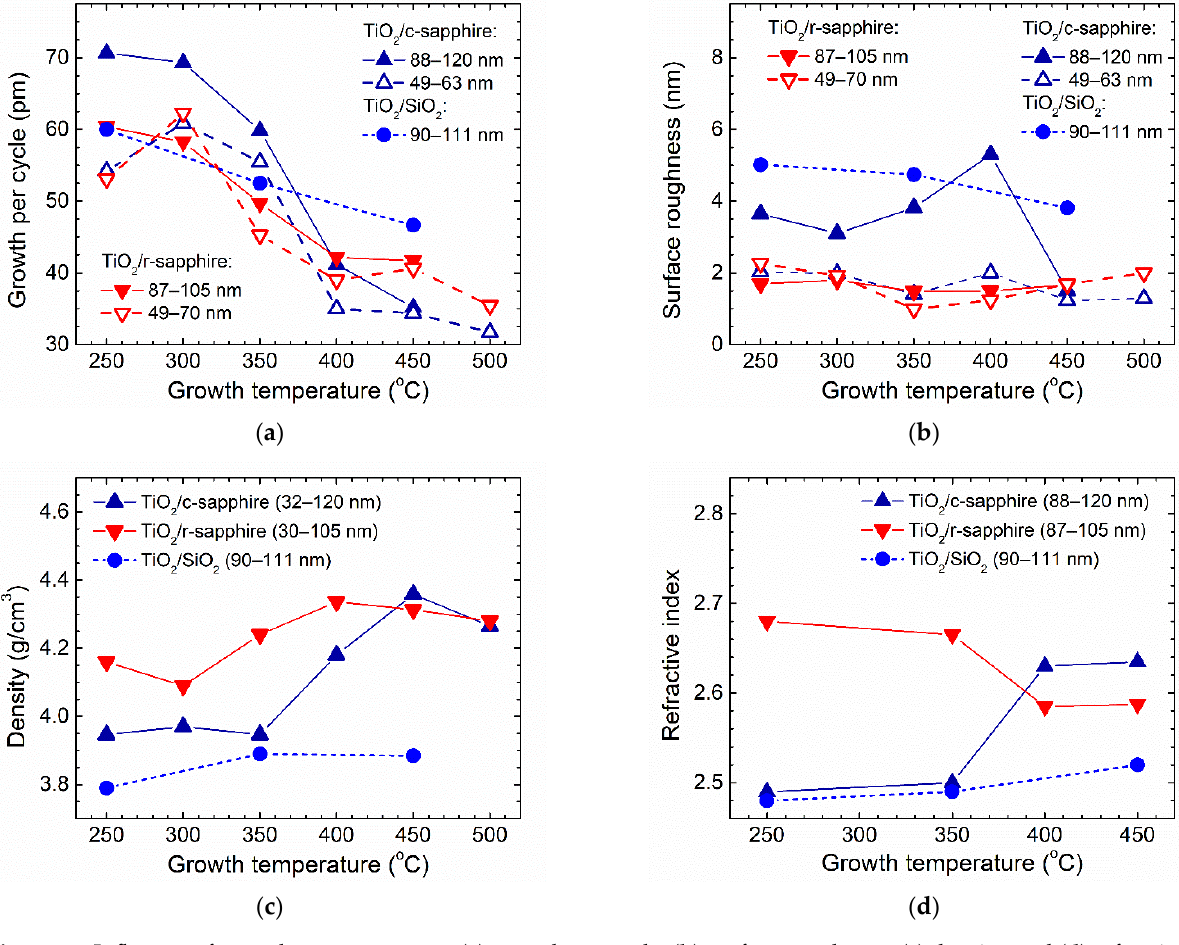
Figure 10. Influence of growth temperature on ( a ) growth per cycle, ( b ) surface roughness, ( c ) density, and ( d ) refractive index determined at a wavelength 633 nm. Thickness ranges of the films characterized are shown in the figure. With a T G increase from 300 °C to higher values, the GPC decreased on all substrates used. However, the decrease was smaller on the SiO 2 substrates where predominantly anatase grew, at all temperatures used in this work. On the c-sapphire substrates, the most significant changes in the crystal structure appeared with a T G increase from 350 to 450 °C (Figures 2 and 3). Correspondingly, the biggest decrease in GPC of the films deposited on those substrates was also observed in this T G range. As a result, the GPC values of the films deposited on different substrates at 450–500 °C markedly differed from each other; the highest values being for the anatase films deposited on SiO 2 , and the lowest values for the TiO 2 -II/rutile films grown on c-sapphire (Figure 10a). Expectedly, the lowest surface roughness values determined by XRR were obtained for the films that were deposited on c-sapphire at 450–500 °C and on r-sapphire at 350– 450 °C (Figure 9b). These films exhibited also a well-developed preferential (1 0 0) orien- tation of lattice-matched TiO 2 -II and rutile on c-sapphire (Figure 3) and the (1 0 1) orien- tation of rutile on r-sapphire (Figure 2b). Interestingly, the thicker films deposited on c- sapphire at 400 °C showed the highest surface roughness values (Figure 10b). At other T G used, the films with the highest surface roughness values grew on the SiO 2 substrates. No considerable effect of the thickness on the surface roughness was observed for the films grown on c-sapphire at 450 °C and on r-sapphire at 250–450 °C. Therefore, the preferential orientation of crystallites and the absence of the anatase phase in the films seemed to be a precondition for obtaining films with smooth surfaces.